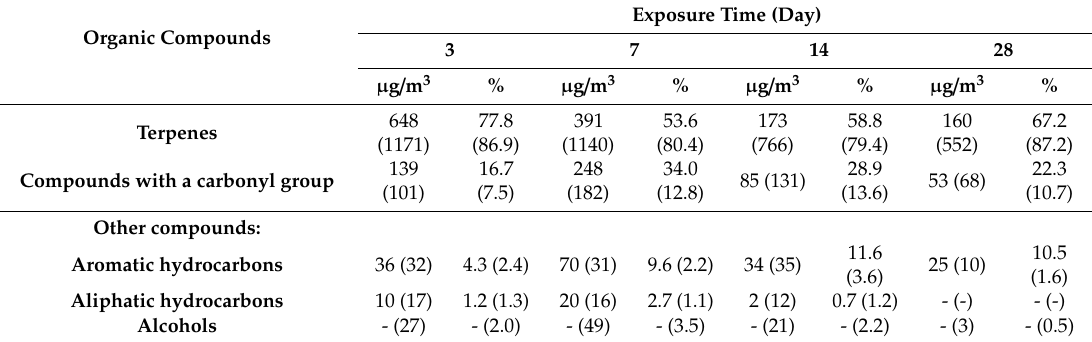
Table 4. Concentration of volatile organic compounds emitted from heartwood and sapwood part of European larch wood ( Larix decidua Mill.) after 3, 7, 14, 21 and 28 days of exposure of samples (values in brackets represent sapwood).